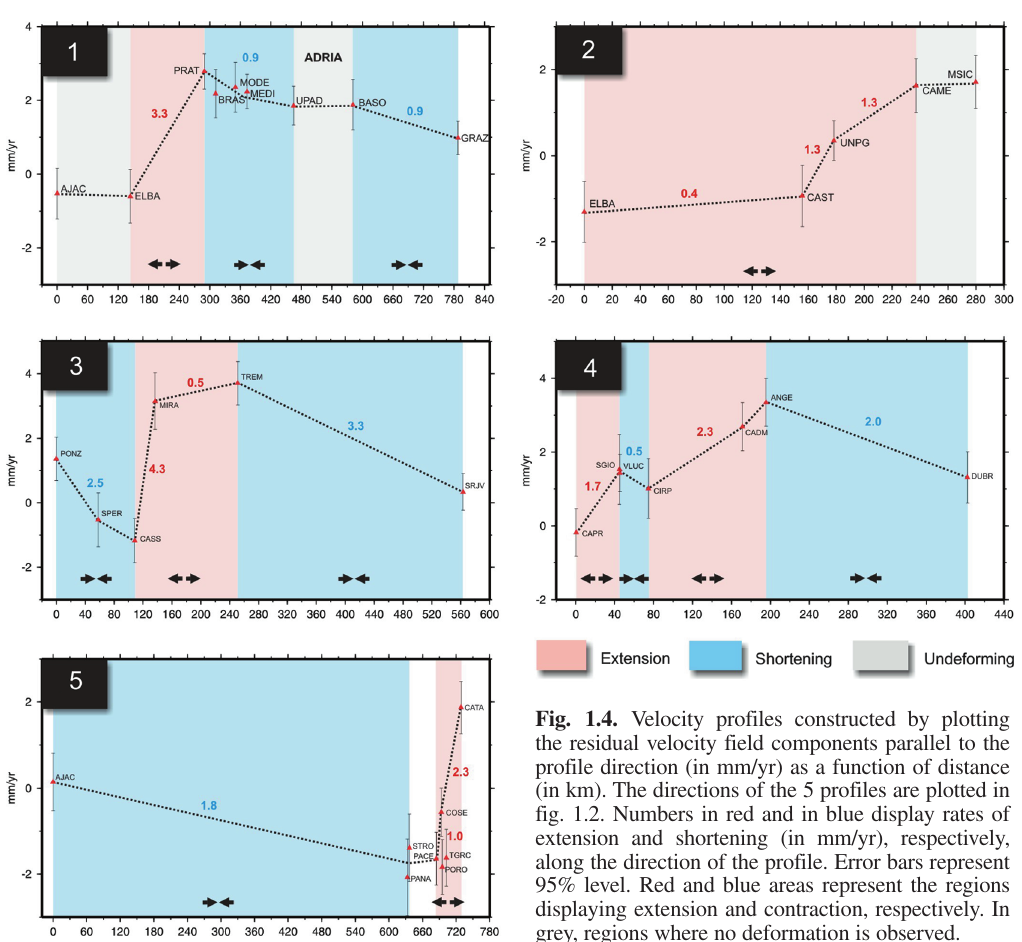
Fig. 1.4. Velocity profiles constructed by plotting the residual velocity field components parallel to the profile direction (in mm/yr) as a function of distance (in km). The directions of the 5 profiles are plotted in fig. 1.2. Numbers in red and in blue display rates of extension and shortening (in mm/yr), respectively, along the direction of the profile. Error bars represent 95% level. Red and blue areas represent the regions displaying extension and contraction, respectively. In grey, regions where no deformation is